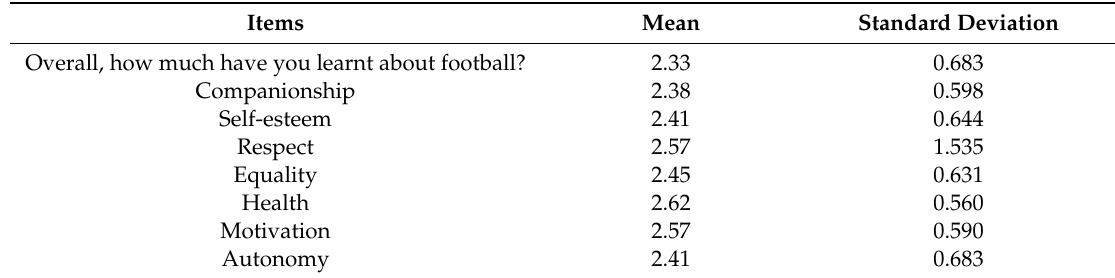
Table 3. Respondent’s learning of the values worked on in the program. Mean Standard